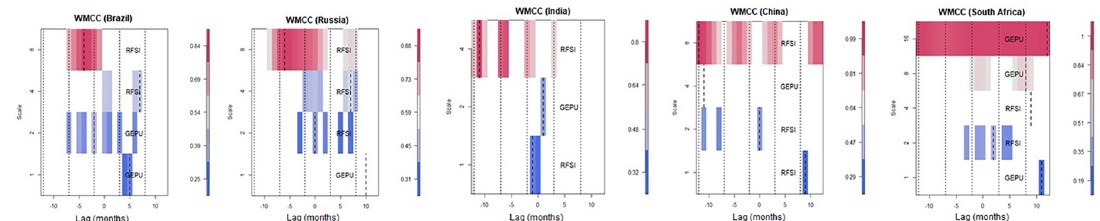
Fig 8. Wavelet multiple cross-correlation among FSI, GDP and GEPU in BRICS.